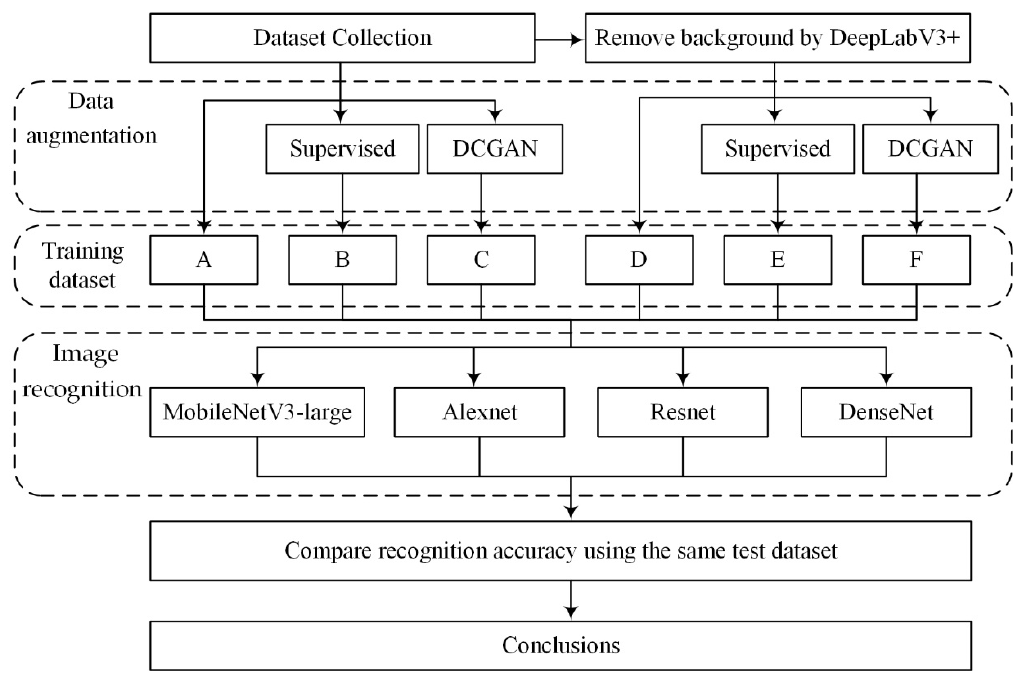
Figure 1. Research Roadmap: A, original dataset; B, original dataset with supervised data augmentation; C, original dataset with DCGAN augmentation; D, background-removed dataset; E, background-removed dataset with supervised data augmentation; and F, background-removed dataset with DCGAN augmentation.